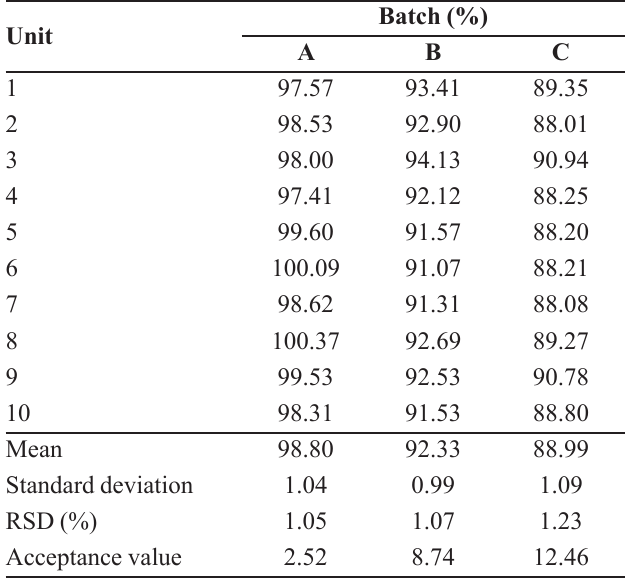
TABLE VI - Results from assay of three batches of